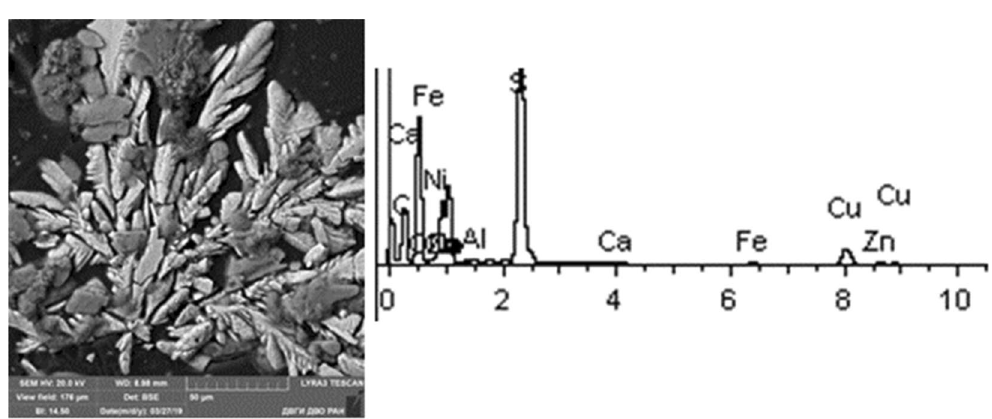
Figure 10. Cathodic degreasing 4. Particles morphology. Scanning electronic microscopy. Measuring interval 50 µm.